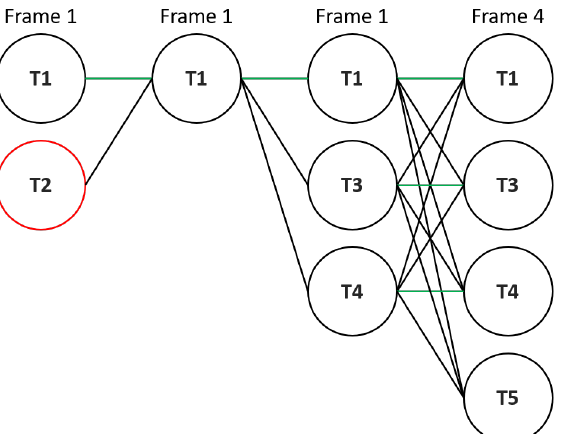
Figure 4. Track tree proposed in Track tree method system overview. The strength of each branch depends on a score evaluated by the matching algorithm. The green lines indicate matched tracks. The red circle indicate a lost